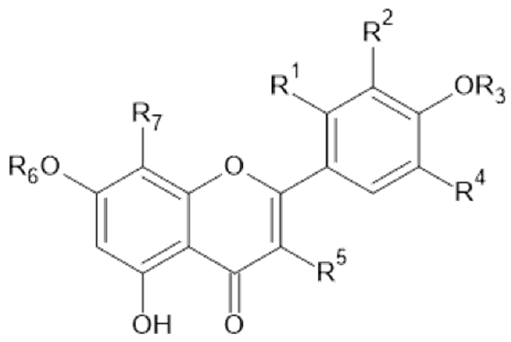
Figure 6. Luteolin and isorhamnetin, and derivatives.